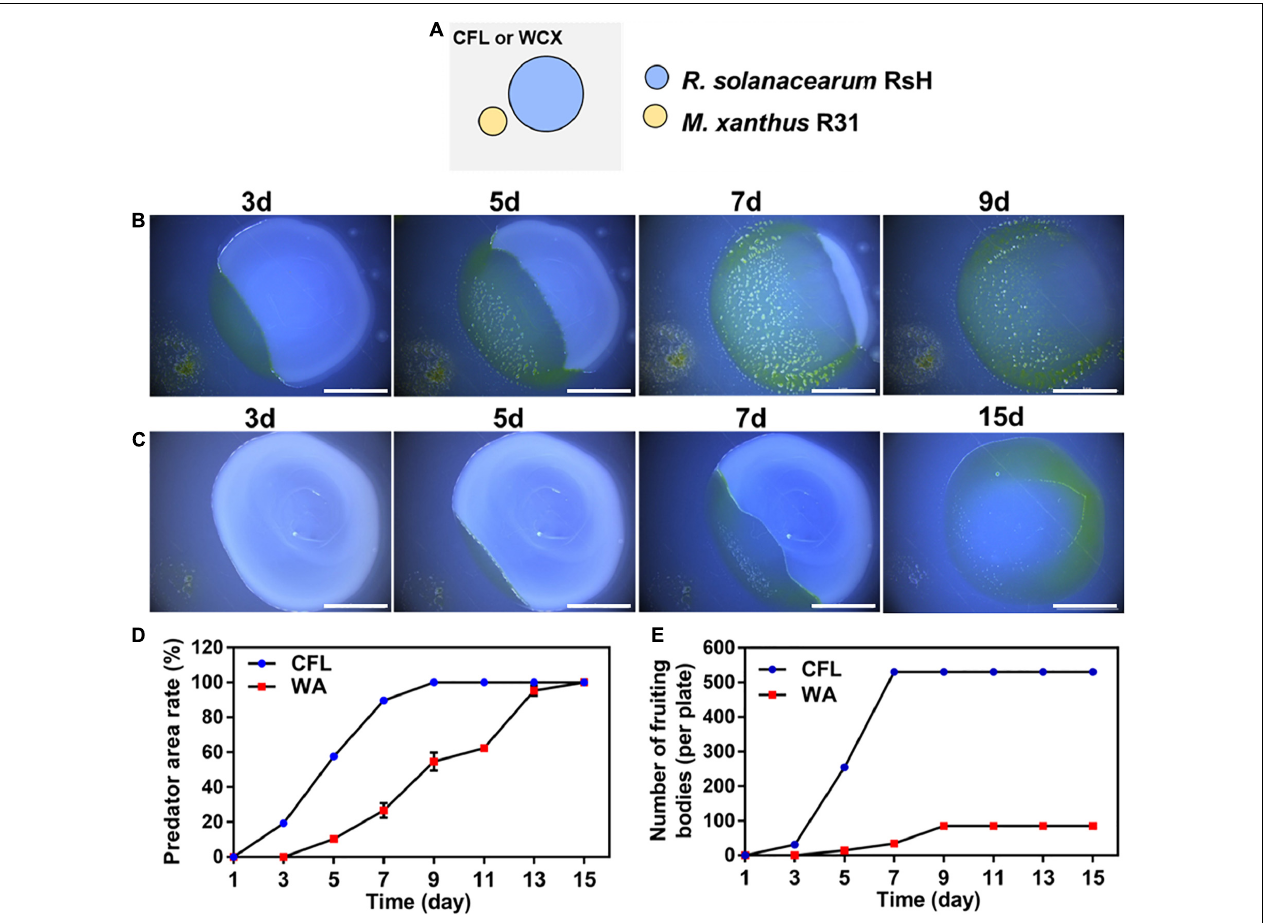
FIGURE 3 | Predation activity of strain R31 against RsH on CFL and WA media. Schematic of the predation assay (A) , 100 µ L RsH cell suspension was pipetted onto the CFL (B) and WA plates (C) and allowed to dry, and then 4 µ L of strain R31 suspension was spotted at 2 mm distance from the prey colony, scar bar = 5 mm; Predator area ratio on two different media (D) and the numbers of strain R31 fruiting bodies formed on two media (E) was calculated. Triplicate experiments were performed, and the averages and standard deviations are